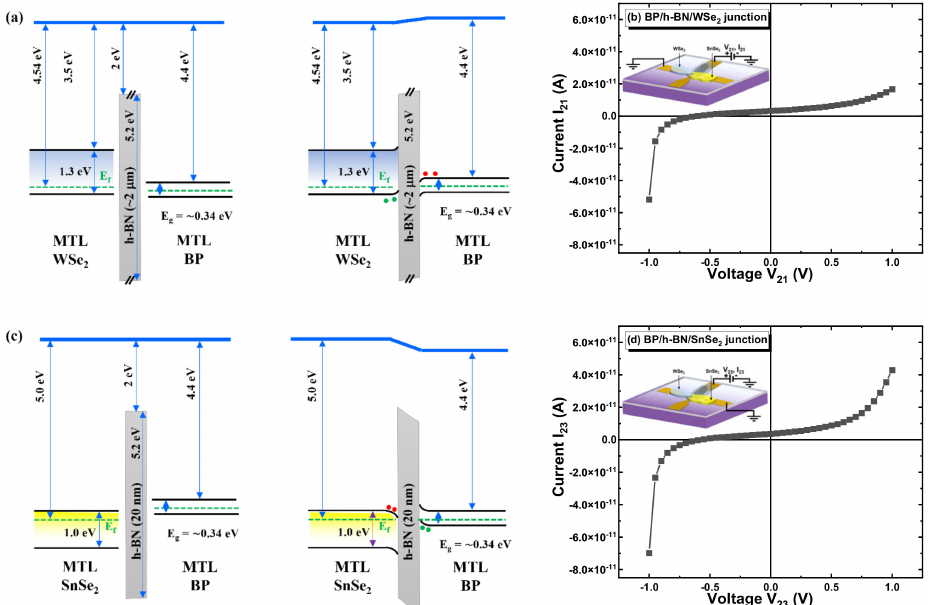
Figure 3. Energy band diagram of ( a ) p-WSe 2 /h-BN/BP and ( c ) n-SnSe 2 /h-BN/BP vdW heterostruc- tures. I–V curves in vertical directions for ( b ) p-WSe 2 /h-BN/BP and ( d ) n-SnSe 2 /h-BN/BP vdW